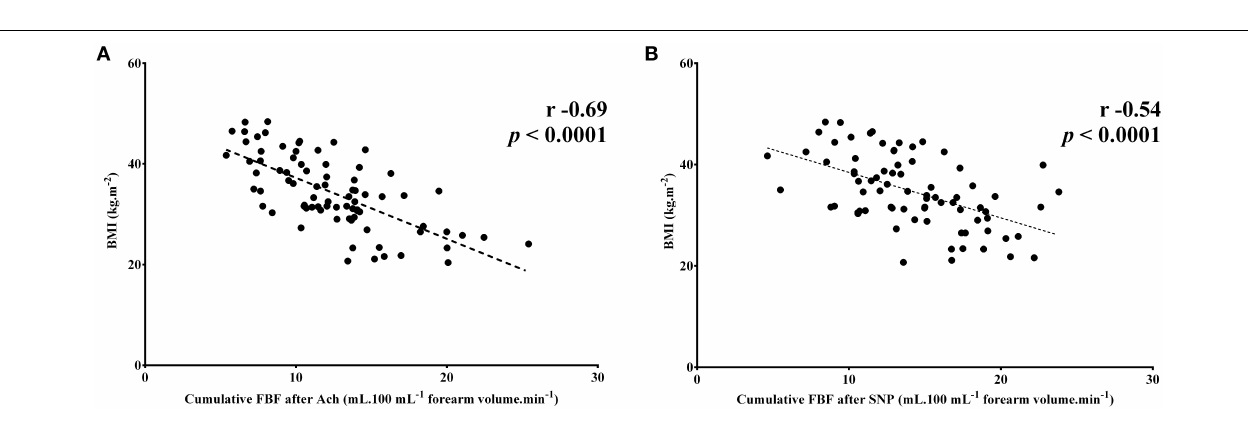
less the BMI is, the better the cumulative response to the progressive doses of vasodilators are. Spearman correlation coefficient and p -values for univariate analysis are shown for each correlation. n = 80